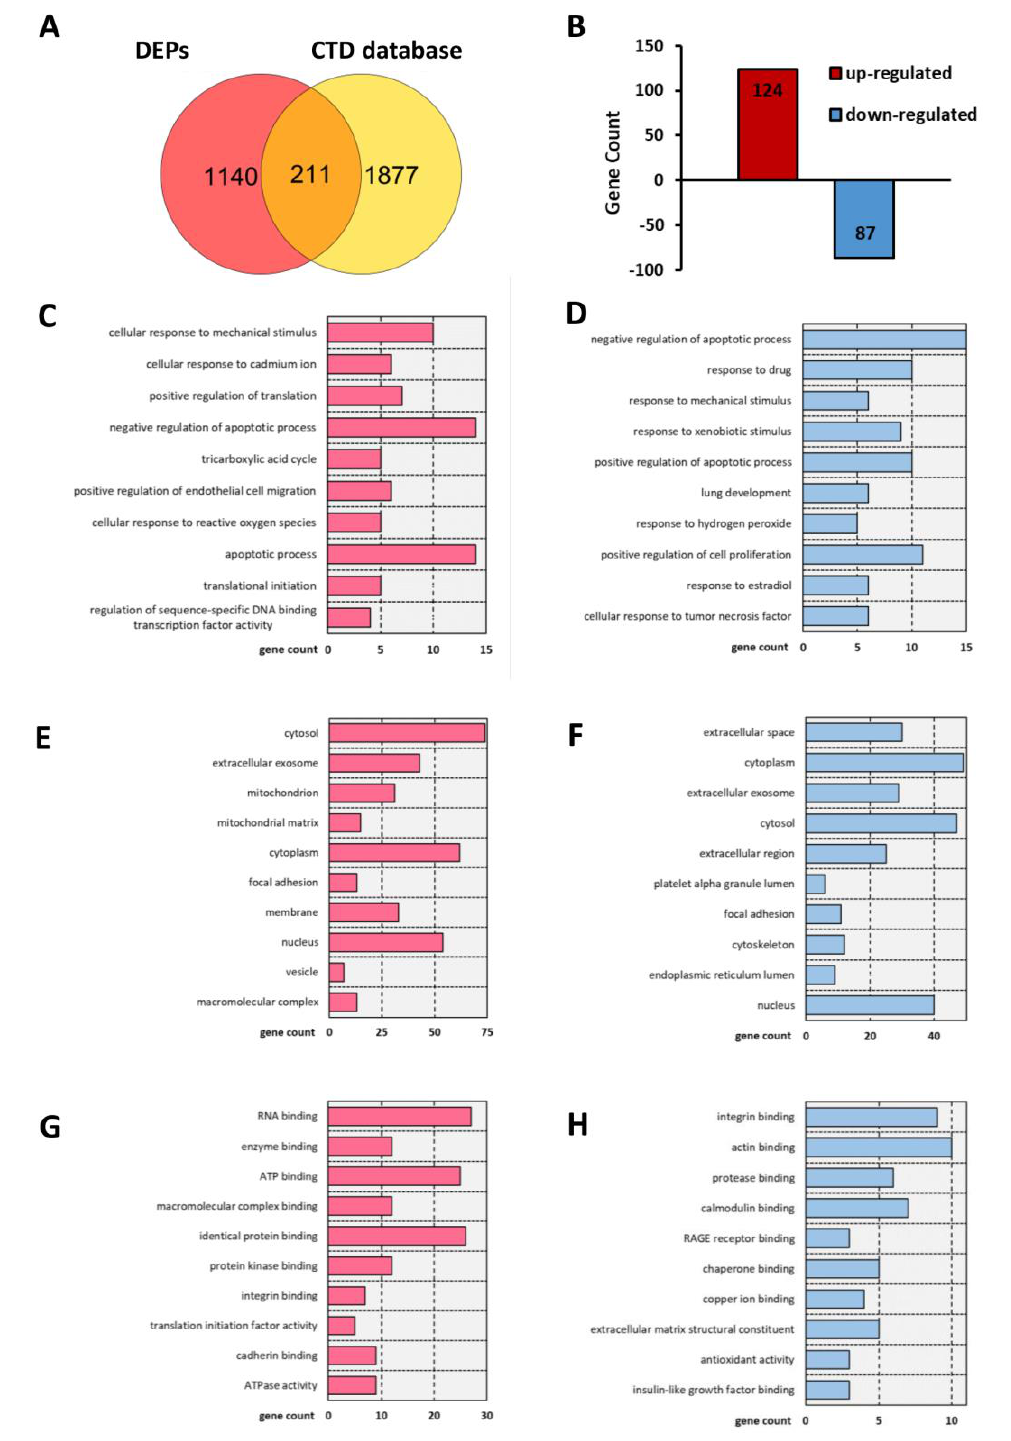
Figure 3. T Bar charts of the GO analysis results including BP, CC, and MF terms for 211 common genes. ( A ) Venn diagram showing the overlap of genes between DEPs and CTD-based AAD-related genes. ( B ) Bar charts of the up- and downregulated common molecules between DEPs and CTD-based AAD-related genes. ( C , D ) Enriched terms in the BP category for ( C ) upregulated and ( D ) downregulated common genes. ( E , F ) Enriched terms in the CC category for ( E ) up-regulated and ( F ) downregulated common genes. ( G , H ) Enriched items in the MF category for ( G ) upregulated and ( H ) downregulated common genes.